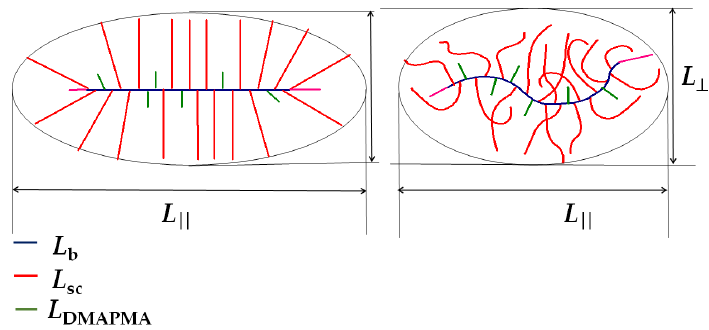
Figure 4. The simplified molecular image for polyOPG 8 OEG 8 MA-DMAPMA 80:20.